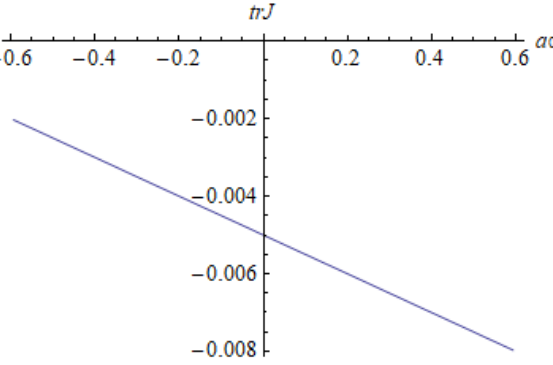
Figure 4. Variation of trJ with respect to amplitude a 0 , given by Equation (77) .